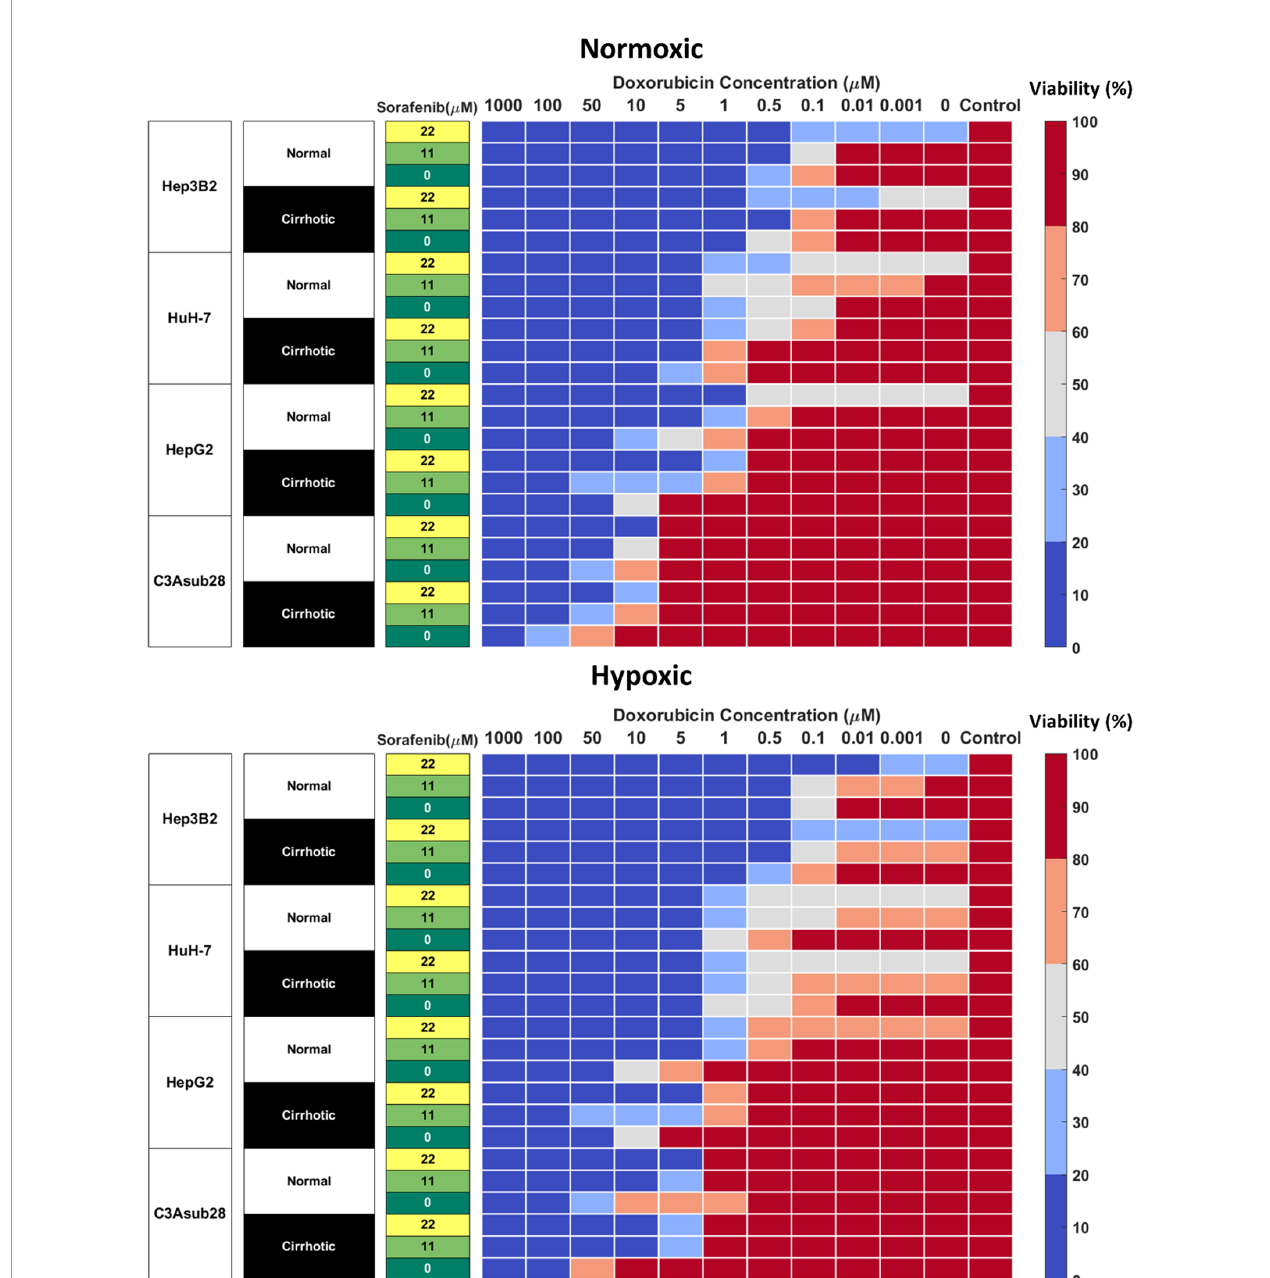
FIGURE 4 | Combined doxorubicin and sorafenib treatment ef fi cacy of HCC cell lines under the in fl uence of hypoxia and cirrhosis. HCC cell types show sensitivity to combined sorafenib and doxorubicin treatment for 24 hours. Cells cultured in 3D normal and cirrhotic hydrogels in hypoxic and normoxic conditions. Cell viability was analyzed and plotted as a percentage of the untreated control. A combination of doxorubicin with sorafenib improves treatment ef fi cacy. The in fl uence of cirrhosis decreased HCC cell